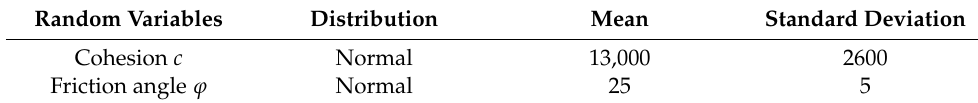
Table 8. The statistical parameter of soil strength for soil slope.